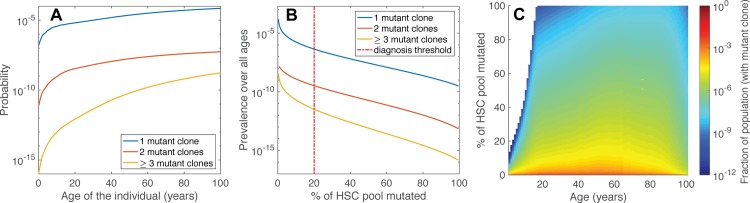
Dynamics of mutant cells and incidence of PNH derived from in silico studies.A. The probability of clinical PNH occurring in an individual between the ages of 1–100 years. Blue: patients with one active clone. Red: patients with 2 active clones. Yellow: patients where 3 or more active clones occurred. B. Expected incidence of clinical PNH in the US population, found by folding the Markov chain probabilities for ages 1–100 with population data from the 2010 US census. Same color codes as in A. C. The distribution of all individuals with a mutant clone in the 2010 US census population over the ages 1–100 and clone sizes 1%-100%.